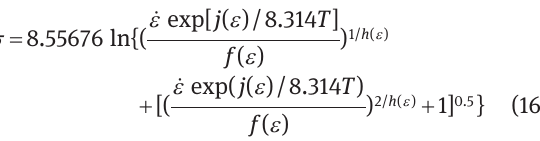
The flow stress level decreases with increasing tem- perature and decreasing strain rate, and such influ- ence can be described by a Zener-Hollomon param- eter in an exponential type function. Q , n , a , and A of material constants are included in the Zener- Hollomon parameter and the constants display signif- icant dependence on the magnitude of strain.